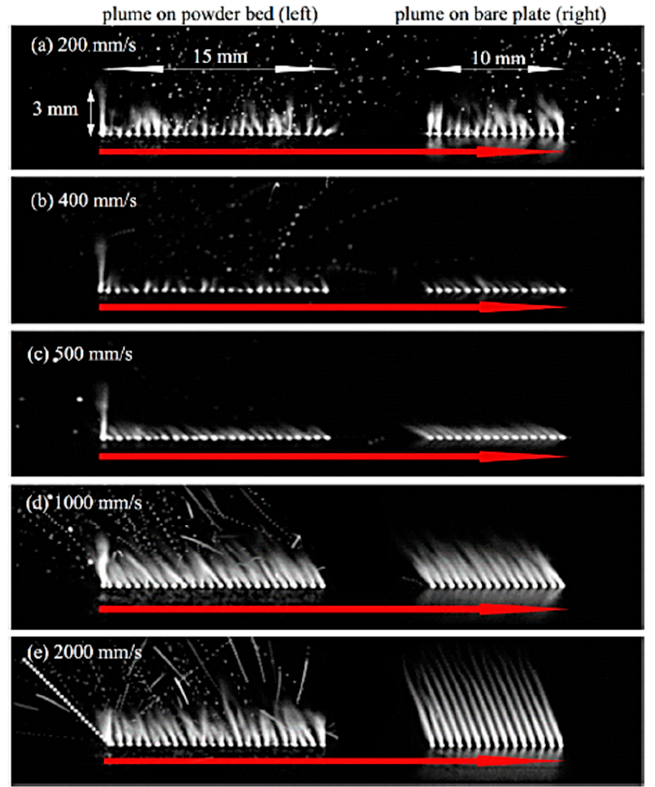
Figure 5. Images of plume and spatter formation under different scan speeds (500 W, 304L stainless steel). Reproduced from Reference [116] with permission from Elsevier.